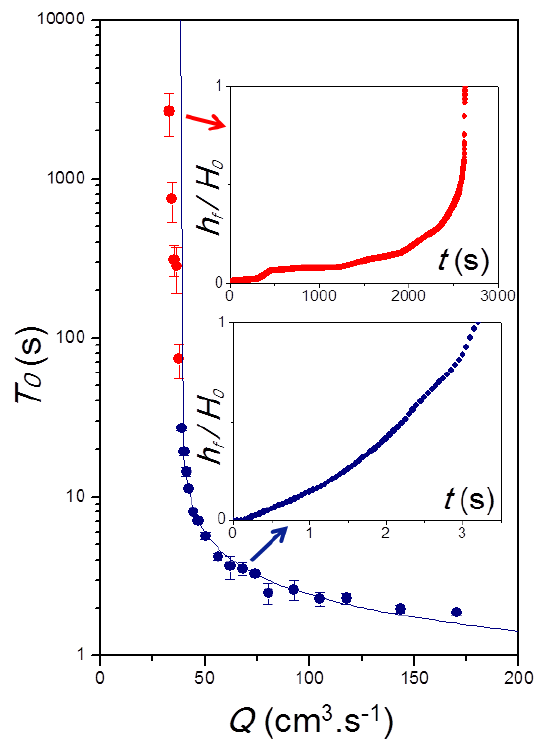
Figure 3. Transient duration T 0 versus injection flow rate Q for = 125 mm . The blue symbols d = 3 mm , D = 30 mm , and H 0 account for the regular regime where a power law divergence is observed (Eq. 3.1 represented by the blue solid line) while the red symbols correspond to the ultra-slow regime as discussed in the text. Insets: typical time evolution of the fluidized height h f in the ultra-slow regime (top and red symbols) and in the regular regime (bottom and blue symbols).